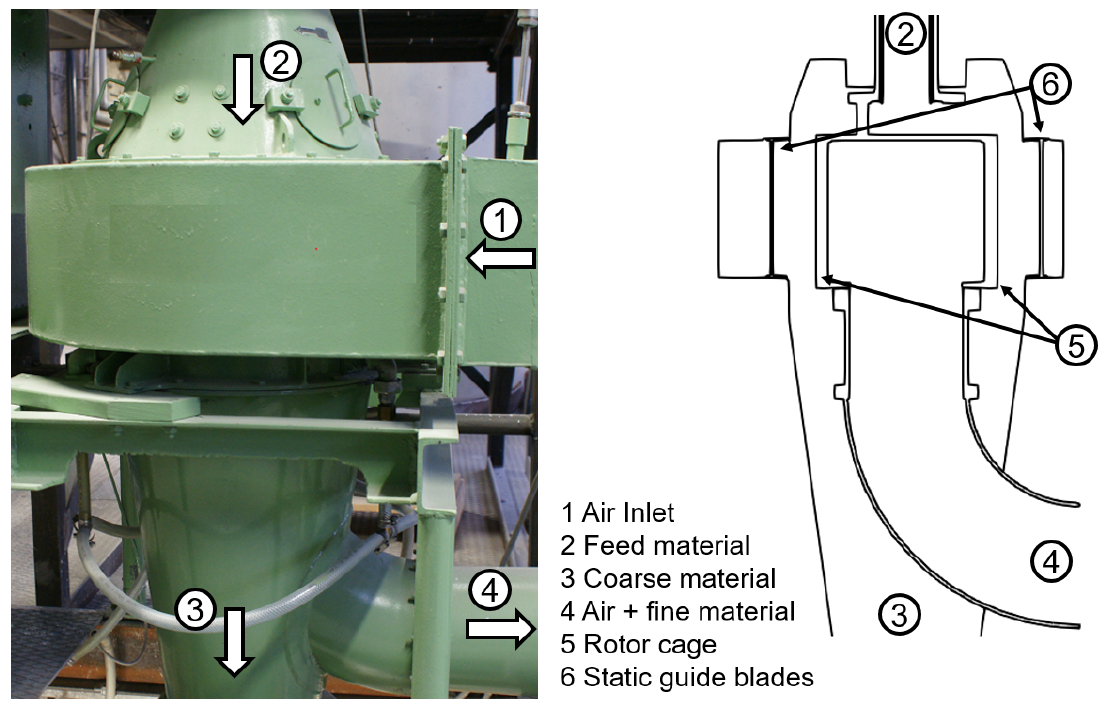
Figure 1. A schematic view of the investigated classifier [ 22 ].